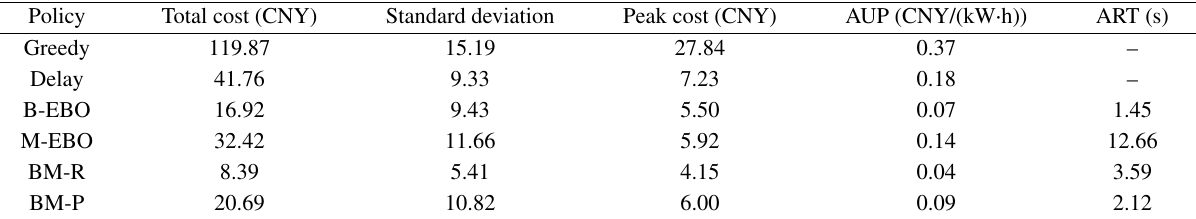
Table 3 Optimization results of different